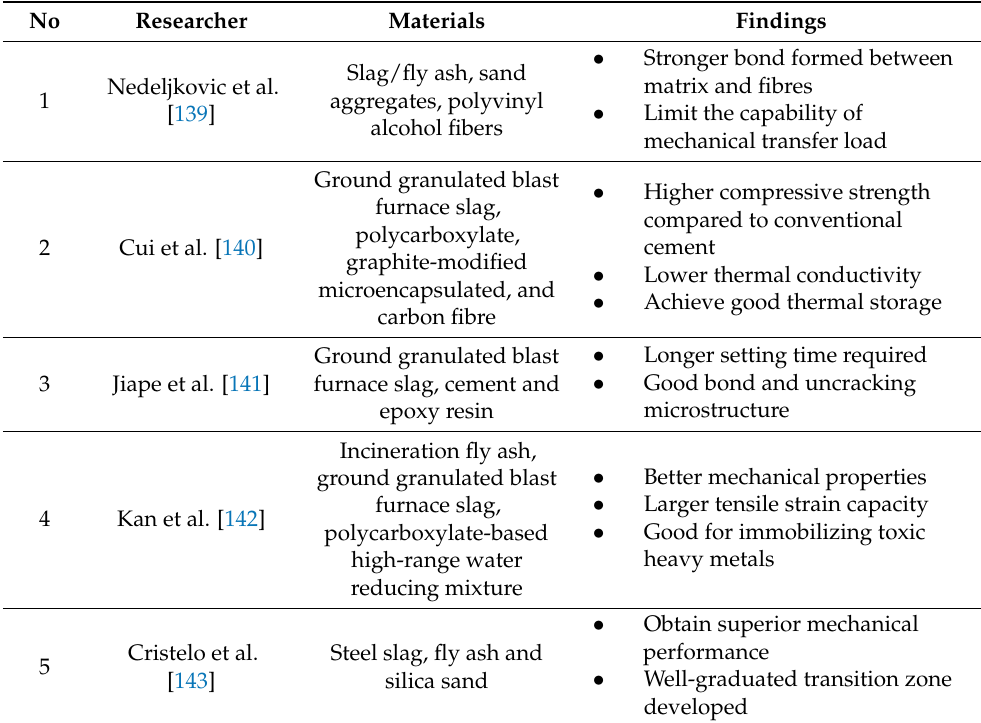
Table 9. Research work utilizing on alkali-activated slag